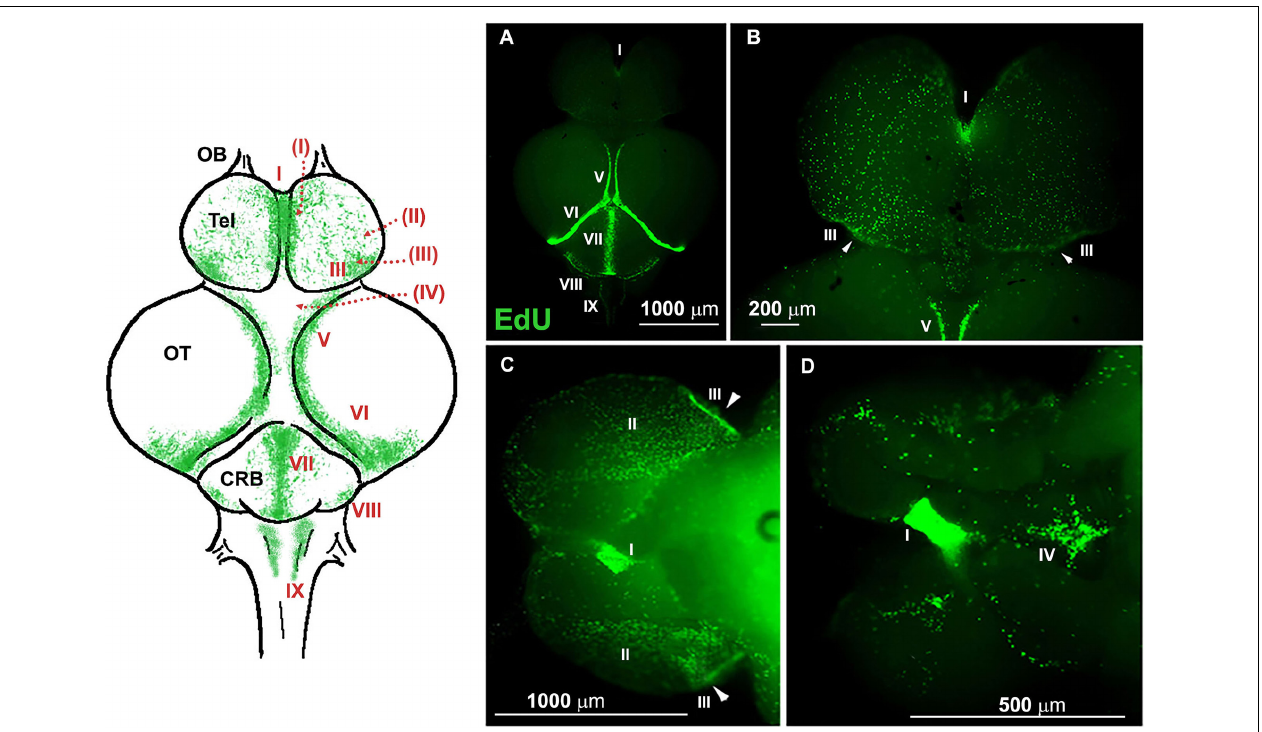
FIGURE 3 | Whole-mount (WM) overview of ethynyl deoxyuridine (EdU) + cells in 7-weeks-old Nothobranchius furzeri , 4 h after intraperitoneal injection (modified from Tozzini et al., 2012). A schematic drawing of the dorsal view of N. furzeri brain is shown on the left , where all principal brain regions are defined (OB, olfactory bulb; Tel, telencephalon; OT, optic tectum; CRB, cerebellum), and neurogenic niche distribution indicated by green dots and sequential Roman numeral indexes; dotted red lines indicate the extension of a niche (or part of it) on the ventral side of the cerebral structure, here not represented. (A) Dorsal view of the brain. (B) Telencephalic region. (C,D) Ventral view of the brain at lower (C) and higher (D) magnification. Nine neurogenic niches are identified in these panels: I, telencephalic niche corresponding to the subpallial region; II and III, telencephalic niches corresponding to the pallial regions; IV, preoptic niche; V, rostro-dorsal part of the niche in the optic tectum (OT); VI, caudal part of niche in the OT; VII and VIII, medial and caudal niches of the cerebellum; IX, caudal niche along the roof of the IV ventricle, visible in panel (A) . Arrowheads (B,D) indicate areas of higher concentration of proliferating cells in the caudal margin of niche